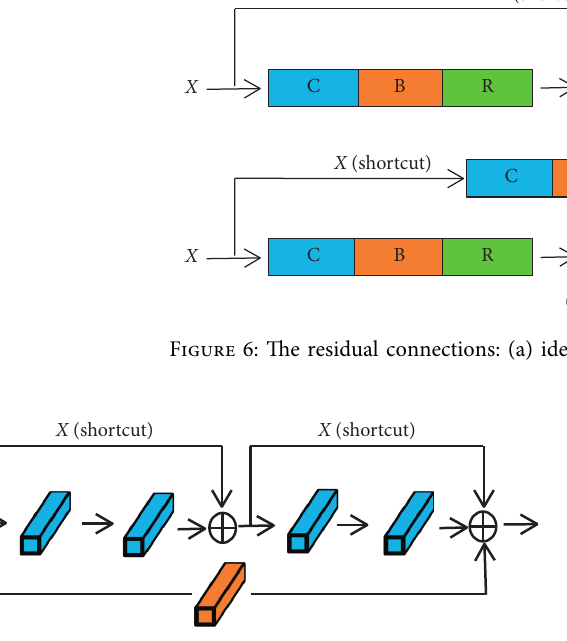
Figure 7: Spectral-spatial residual